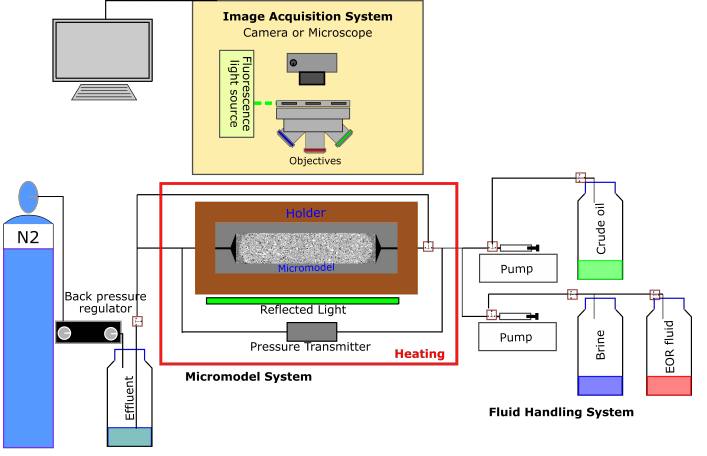
Figure 1. Sketch of the general available experimental setup, which consists of three main components: the fluid handling, the micromodel, and the image acquisition